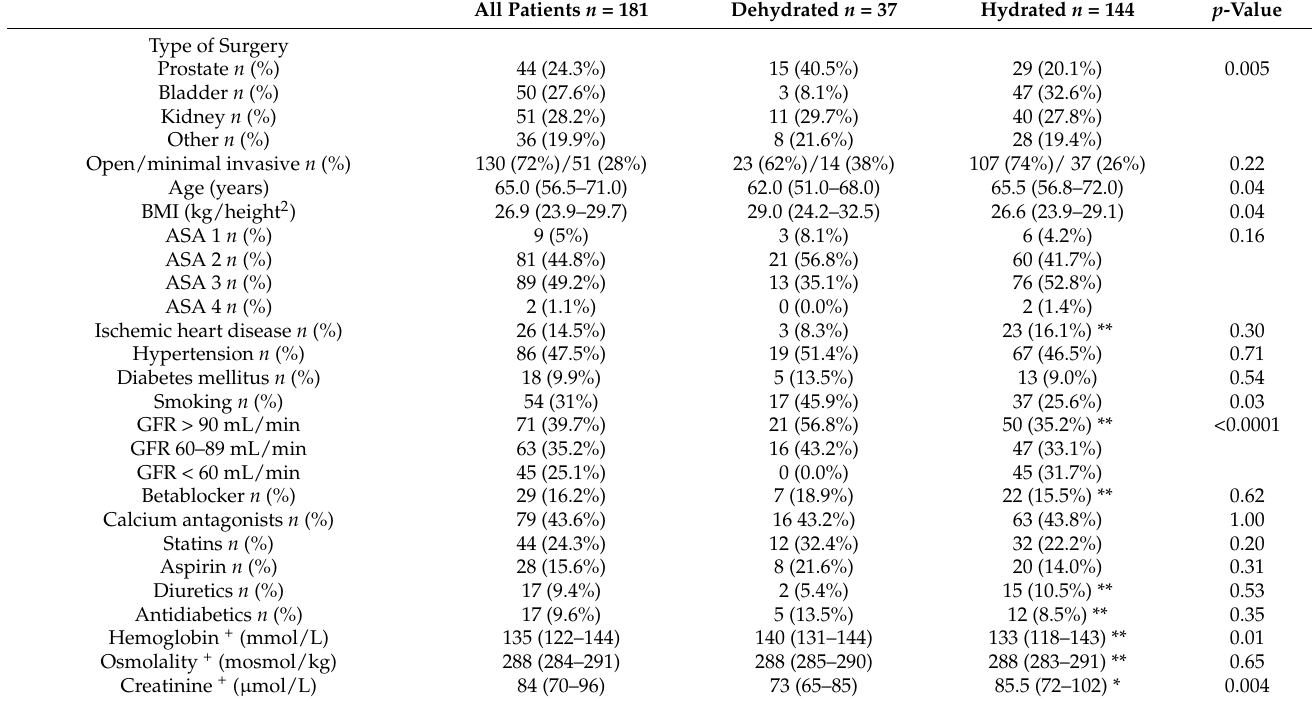
Table 2. Patient’s pre-, intra-, and postoperative data. Dehydration grouping according to fluid retention index (FRI) ≥ 4 obtained when surgery was initiated. Data shown as median (25th–75th percentiles) or block column percentages depending on distribution. + values measured at surgery. Missing data coming from patients in the hydrated group. All Patients n = 181 Dehydrated n = 37 Hydrated n = 144 p -Value Type of Surgery Prostate n